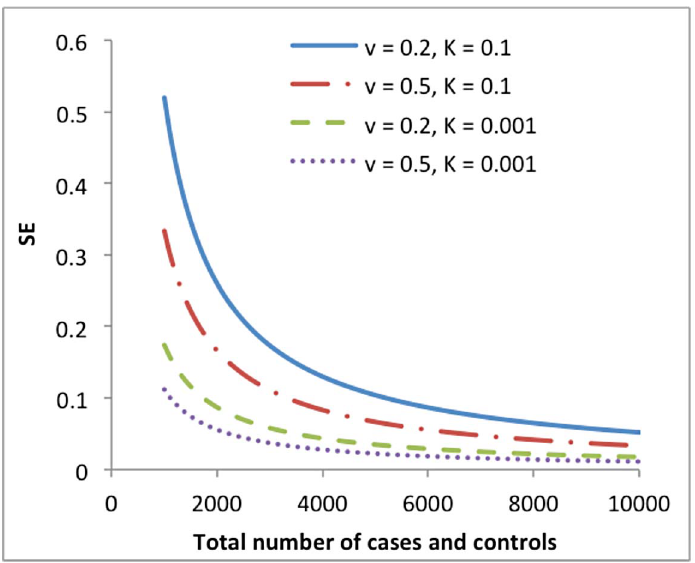
Figure 2. Standard error (SE) of the estimate of variance explained by all SNPs on the underlying scale ( h 2 analysis of a case-control study vs. total number of cases and controls (sample size). The SE is predicted from the approximation theory given different levels of disease prevalence ( K ) and proportion of cases in the sample ( v ).